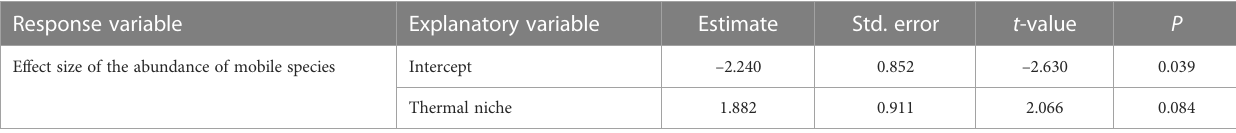
TABLE 7 Results of linear regression analysis testing how the effects of MHWs on the abundance of each mobile species (herbivorous mollusks and carnivorous invertebrates) in 2016 (i.e., considering the accumulative carryover effect) differ depending on thermal niche. Response